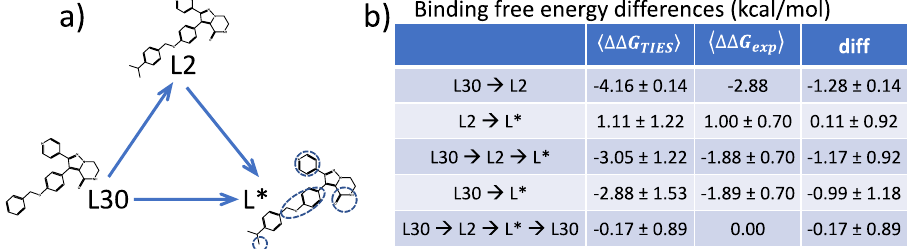
Figure 6. Binding free energy differences in the closed cycle. L* represents 17 compounds which have differences at one or more positions (blue cycles) to L2, and have been paired with both L30 and L2. The errors for L30 → L2 are derived from the bootstrapped standard error from the ensemble simulations. The errors in all other energy terms are the standard deviations of sampling distributions from the 17 compounds. The experimental measurements are reported as single values with no uncertainties